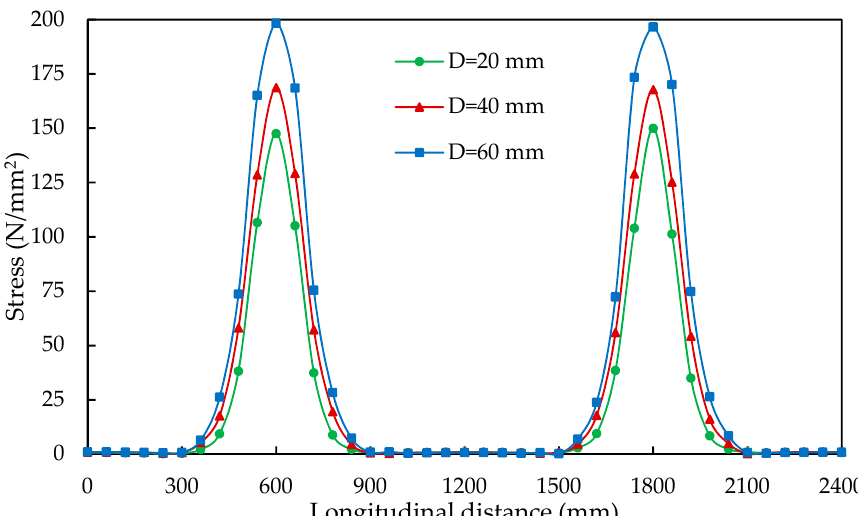
Figure 12. Comparison of maximum steel stress over along the length of the longitudinal steel bar for different saw-cut depths.